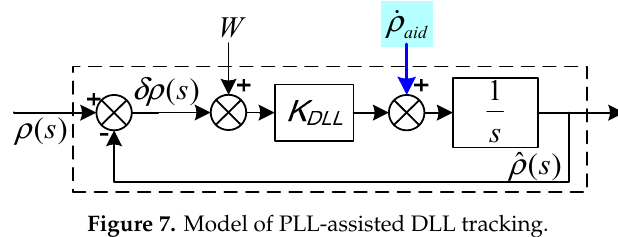
Figure 7. Model of PLL-assisted DLL tracking.